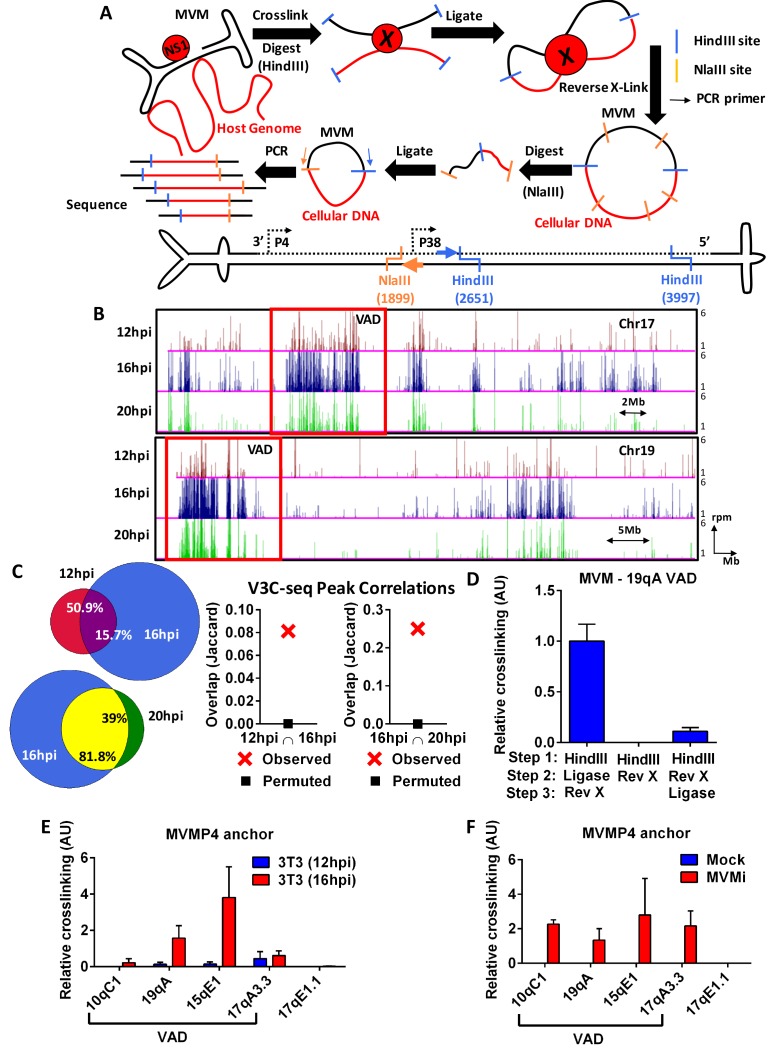
The MVM genome associates with distinct sites on the cellular genome.(A) Top Schematic of the V3C-seq assay showing how MVM- host cell genomic proximity is frozen by crosslinking, followed by digesting (with HindIII) and intramolecularly ligating to generate novel MVVM-host cell DNA hybrids. This DNA library is subjected to a second round of digestion with a frequently-digesting 4 base-pair endonuclease (NlaIII), before circularizing and generating a sequencing library of all hybrid fragments that associate with the MVM genome. Bottom Detailed schematic of the duplex form of MVMp genome containing the primary restriction enzyme site (HindIII) with its associated inverse PCR primer (blue arrow), and the secondary restriction enzyme site (NlaIII) with its associated inverse PCR primer (orange arrow) utilized for circularization. The single stranded version of the genome is depicted in solid black line and complementary strand in dotted black line. (B) Associations of the MVM genome with sites on the cellular DNA mapped using V3C-seq assays are presented. Representative examples of murine chromosome 17 (top) and chromosome 19 (bottom) are shown for three timepoints post-infection: 12 hpi (red), 16 hpi (blue) and 20 hpi (green). The data represents an average of at least 2 independent experiments with y-axis values reflecting the reads per million (rpm) sequence reads averaged over 5 contiguous fragments (as described in Materials and methods). The y-axis scale is from 1 to 6 rpm, whereas the x-axis is 95 Mb for chromosome 17 (top) and 61 Mb for chromosome 19 (bottom). Large genomic regions that associate with MVM, termed Virus Associated Domains (VADs), are shown by red boxes, but this indication is not meant to restrict this nomenclature to regions of this size. (C) Genomic regions spanned by V3C-seq peaks greater than 5 total reads were selected, and the common regions between different timepoints were intersected using BEDTools (see Materials and methods). In the Venn diagrams on the left panel, the red set represents genomic regions that were covered by 12 hpi, blue represents 16 hpi and green represents 20 hpi. The regions common to 12 and 16 hpi are shown in purple (top), while 16 and 20 hpi are in yellow (bottom). The percent of genomic regions that are common are depicted in the intersected set. Statistical significance of the overlap was computed using Jaccard analysis on BEDtools (right panels, red crosses) between the top ten thousand V3C-seq peaks at 12, 16 and 20 hpi timepoints, with control comparisons permuted by determining the extent of overlap with a randomly generated peak file containing domains of equivalent V3C-seq peaks (represented by black squares). (D) 3C-qPCR was performed on synchronized murine A9 cells infected with MVM with an MOI of 5 for 16 hr, as described in Materials and methods, and then analyzed with the viewpoint on the MVM genome. The association of MVM with a HindIII site in the Chr19 VAD (at position 19qA) was quantified relative to nearest neighbor interactions of contiguous HindIII fragments on the Ercc3 locus. 3C-qPCR analysis was performed in (E), parasynchronized NIH-3T3 cells infected for 12 and 16 hr with MVMp, and (F), EL4 cells with MVMi, assayed from the MVM viewpoint. Association was tested with four VADs (10qC1, 19qA, 15qE1 and 17qA3.3) and a negative control site on Chromosome 17 (17qE1.1). Data is presented as mean ± SEM of three independent experiments.